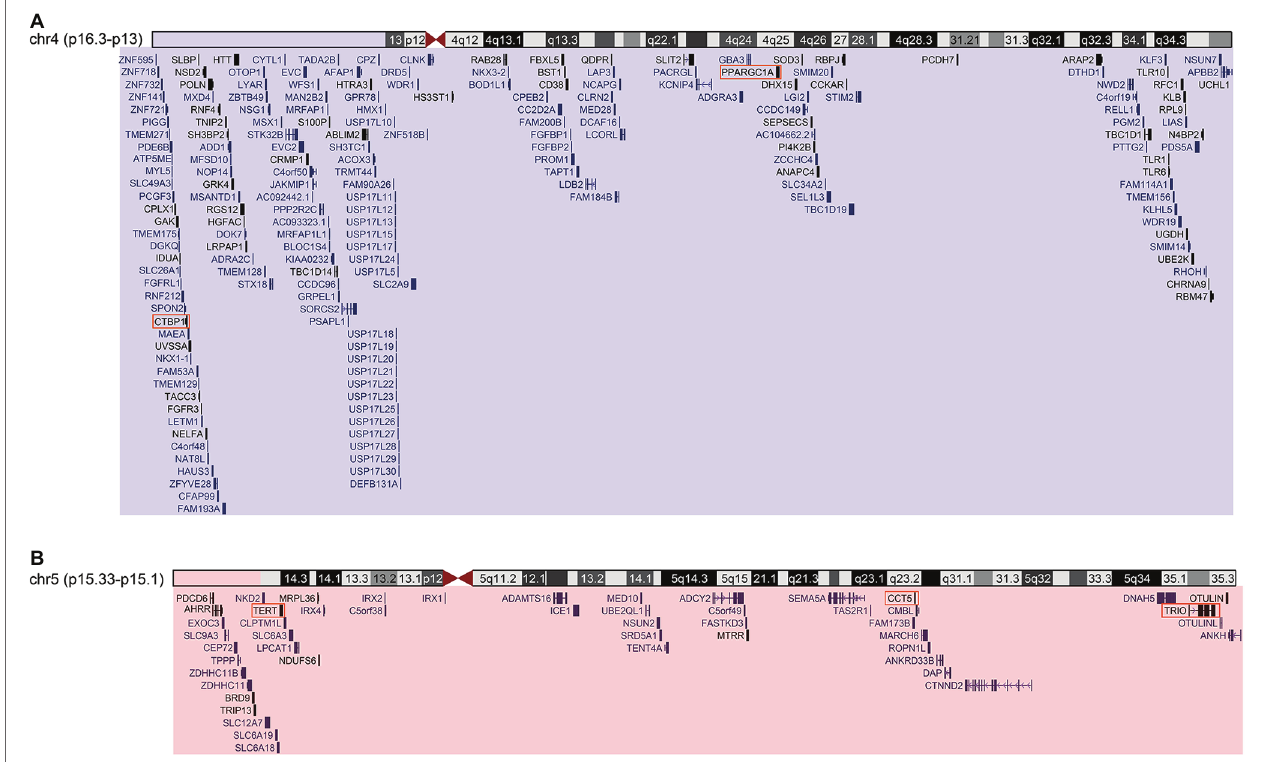
FIGURE 2 | (A) Cytogenomic profile of the region of chromosome 4 duplication. Segment duplicated highlighted in blue rectangle. UCSC-Genome Browser- Dec.2013 (GRCh38/hg38) – genomic position/search term: chr4:71552-41263831 – track: GENCODE V29. (B) Cytogenomic profile of the deleted region of chromosome 5. Segment deleted highlighted in red rectangle. UCSC-Genome Browser-Dec.2013 (GRCh38/hg38) – genomic position/search term: chr5:269963- 15032936 – track: GENCODE V29. Orange squares are genes considered